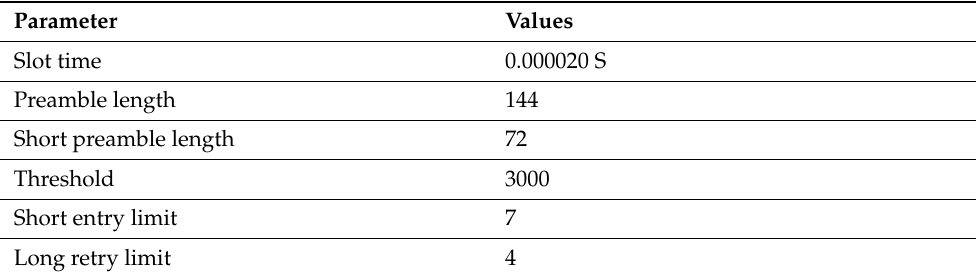
Table 7. Different degrades